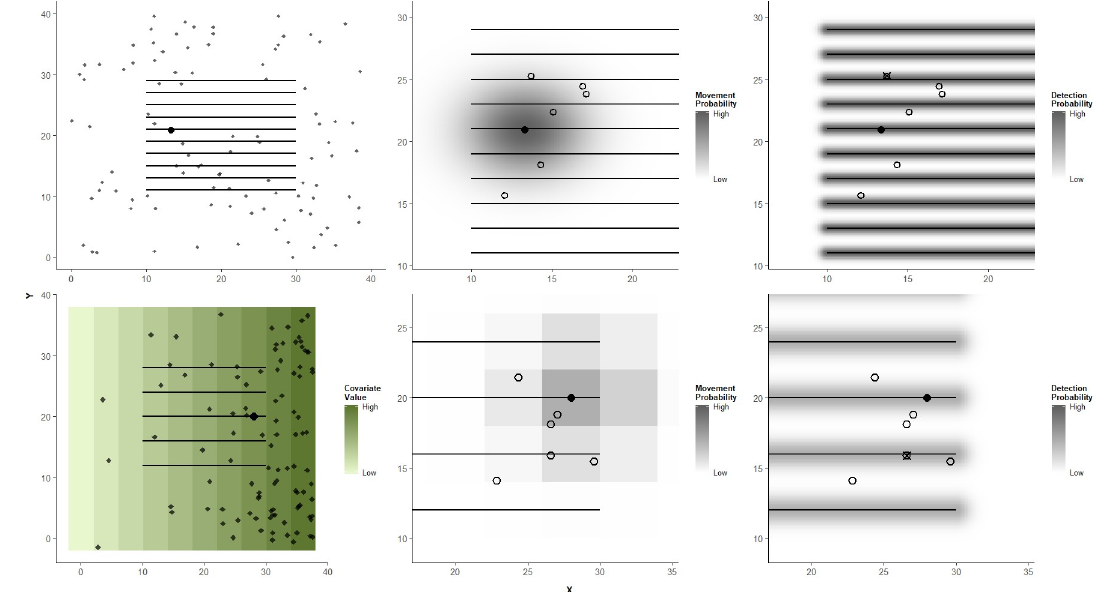
Fig 1. Simulated datasets. Examples of simulated datasets following a spatial capture-recapture model where density was uniform across the state space (top row) or a function of a spatial covariate in the state space (bottom row). Each individual was associated with an activity center, depicted by the points in the left column. Individuals were located around their respective activity centers on each sampling occasion, represented for one individual by the open circles in the middle column. The probability of an individual moving to a particular location during an occasion was a function of the distance from its activity center, with the individual being more likely to be located close to rather than far from the activity center. These locations were also distributed as a function of the spatial covariate in the spatial covariate scenario (bottom row). Line transect surveys, represented by the horizontal lines, were conducted during each sampling occasion. The probability that an individual was detected on an occasion was a function of the distance between its location on that occasion and the closest point on a transect line, with the probability being higher the closer an individual was to a line (right column). The locations of detections are depicted by the crossed-out circles in the right column.